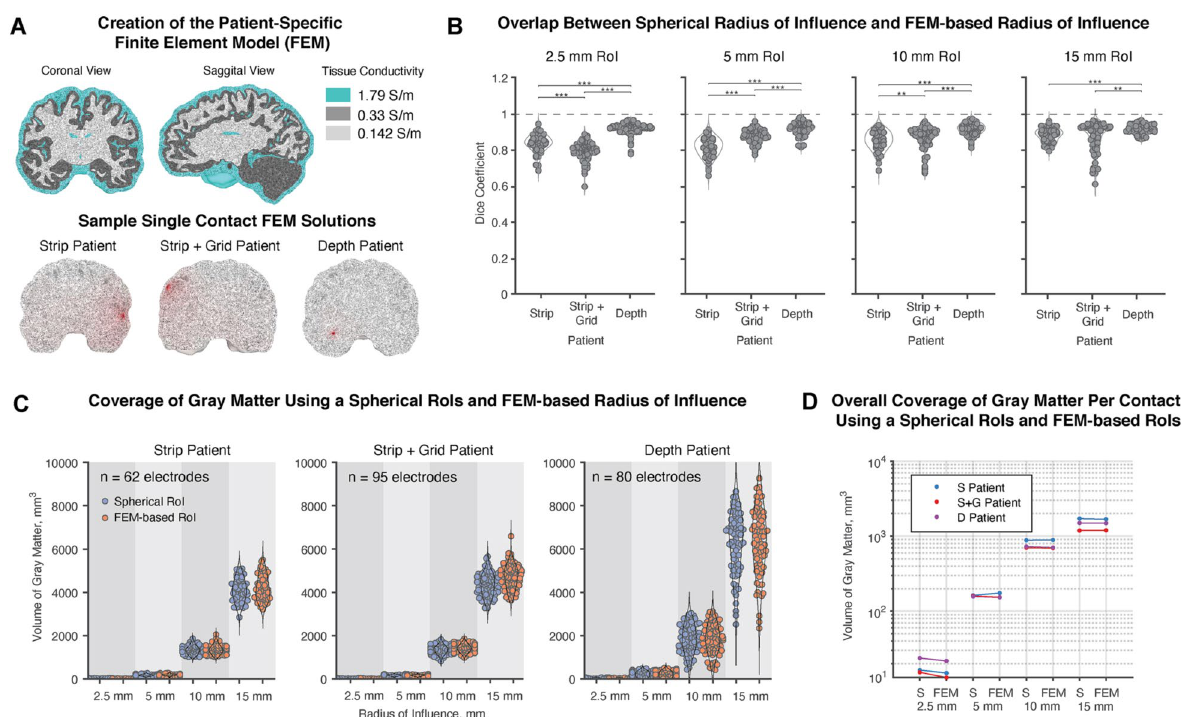
Figure 4. Use of patient-specific brain modeling to create RoIs. ( A ) Using a head mesh generated from a FreeSurfer/SIMNIBS pipeline. The finite element method was used to solve for voltage solutions for all electrodes for 3 patients (1 strip patient, 1 strip and grid patient, 1 depth patient). FEM-based RoI volumes were determined by equipotential lines according to the average voltage at 2.5 mm, 5 mm, 10 mm, and 15 mm away. ( B ) Using the Dice coefficient to measure overlap, FEM-based volumes were not statistically significantly different in shape to spherical volumes. However, depth electrodes had significantly higher dice coefficients than surface electrodes at all RoI sizes (2.5 mm—S & S + G: p = 5.44 × 10 –5 ; S & D: p = 3.09 × 10 –12 ; S + G & D: p = 0; 5 mm—S & S + G: p = 1.54 × 10 –8 ; S & D: p = 0; S + G & D: p = 7.21 × 10 –10 ; 10 mm—S & S + G: p = 5.82 × 10 –3 ; S & D: p = 5.35 × 10 –15 ; S + G & D: p = 1.05 × 10 –7 ; 15 mm—S & D: p = 5.82 × 10 –6 ; S + G & D: p = 0.0013). ( C ) Slight differences in individual FEM-based volumes did not translate to significant differences in the calculated coverage of gray matter. ( D ) Overall, across patients and all RoIs, there was no consistent pattern in how total gray matter coverage changed with the use of a FEM-based RoI, thus, justifying the use of spherical RoIs in our electrode combination. This relationship held in gray matter coverage per contact (Fig. 2B) as well as total gray matter coverage (Supplementary Fig. 1A). Strip electrodes exceeded depth electrodes in gray matter coverage at both 5 mm and 10 mm RoIs; the combined use of strip and grid electrodes exceed depth coverage at a RoI of 10 mm only. This reversal in gray matter coverage is likely due to the typical intercontact spacing of subdural and depth electrodes. With the exception of a few patients, most depth leads in this study had a 5 mm intercontact spacing while all subdural electrodes in this study had a 10 mm spacing. When the RoIs exceeded 2.5 mm for depth electrodes, they overlapped with recording volumes from neighboring contacts, thereby creating redun- dancy in gray matter coverage. This intercontact spacing explains why at greater RoIs, specifically greater than a 4 mm RoI, subdural electrodes sampled more gray matter. Beyond an 8 mm RoI, strip electrodes sampled more gray matter, presumably because strip subdural electrodes have the least amount of redundancy across all the modalities we tested. Tantawi et al. recently reported gray matter coverage using a fixed radius of 2.5 mm 27 . They included 20 patients, with 10 patients in the depth cohort and 10 in the surface electrode cohort. The analysis found that, using a single spherical recording volume with a radius of 2.5 mm, the average per contact coverage was not significantly different across the depth and surface modalities, though depth electrodes sampled more total gray matter volume than surface electrodes. Using a comparable 2.5 mm RoI in our study, we found that depth elec- trodes sampled significantly more gray matter than strip and strip + grid combinations in per contact (Fig. 2B) and total coverage calculations (Supplementary Fig. 1A). The discrepancy across our results and previously reported values is likely due to our use of probabilistic calculations of gray and white matter which offer more precise parcellation of gray and white matter regions within each voxel. Additionally, the majority of SEEG leads in our study used 5 mm intercontact spacing, while Tantawi et al. (2021) used SEEG leads with 3.5 mm inter- contact spacing 27 . We also found it critical to separate strip and strip + grid modalities in our analysis because, at RoIs greater than 8 mm, strip only configurations sampled more gray matter than strip + grid configurations (Fig. 2A). It should also be noted that Tantawi et al. (2021) had larger electrode counts than in our analysis, which may explain why depth electrodes sampled significantly more gray matter in the total gray matter calculation but